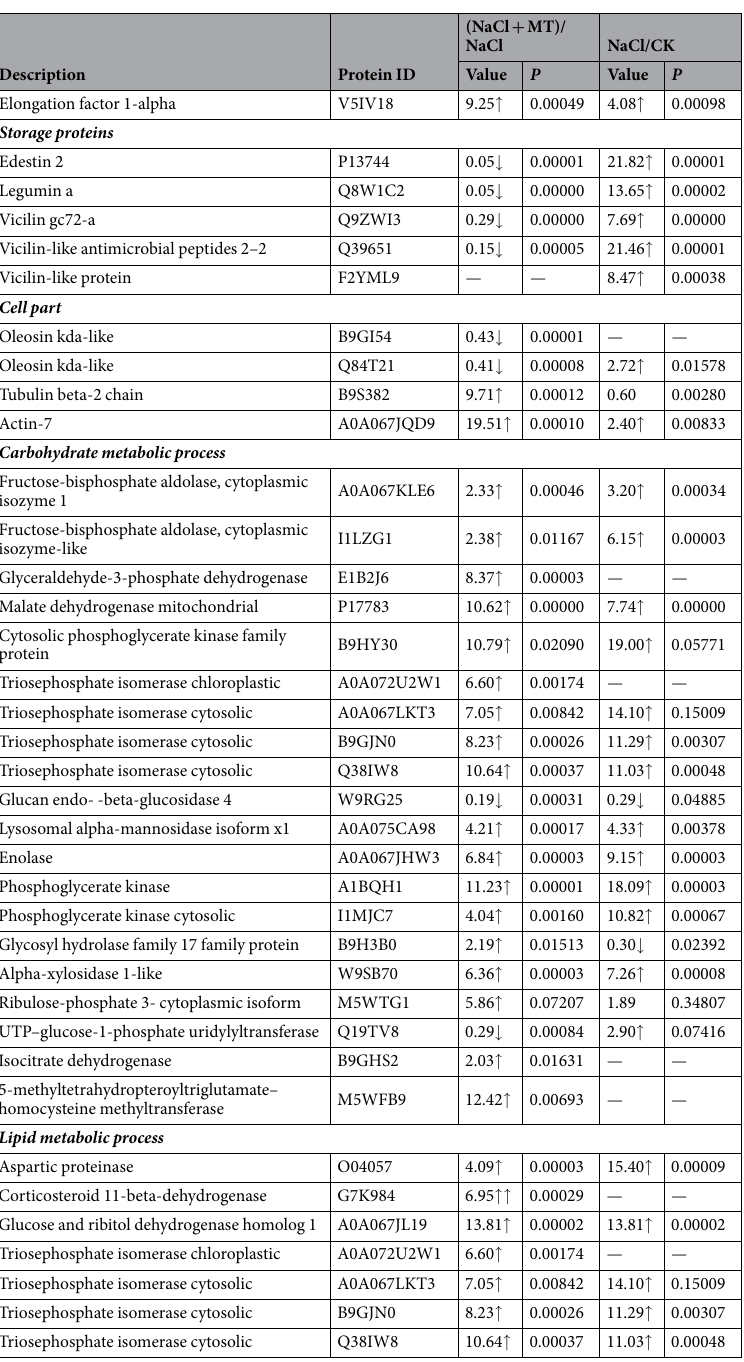
Table 1. Proteins involved in the biological process after melatonin treatment under salt stress. “ ↑ ” indicates increased proteins, and “ ↓ ”indicates significant decreased protein (fold change ≥ 2 or ≤ − 2 and P value < 0.05). “ − “indicates not